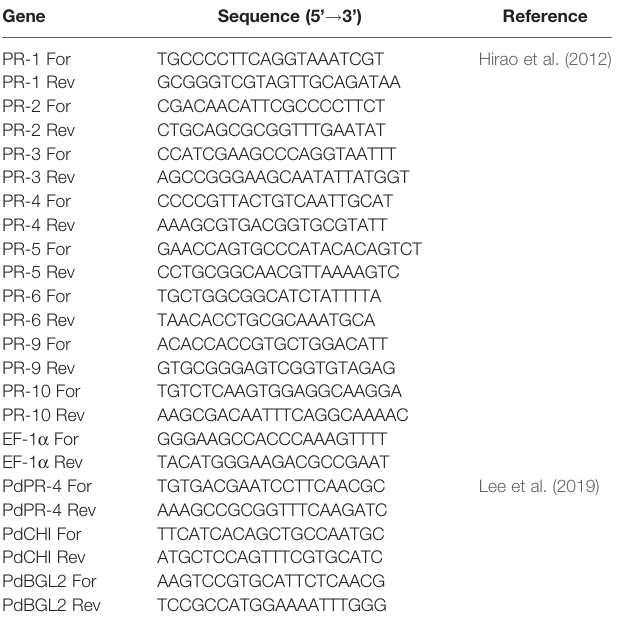
TABLE 1 | Primers used in this